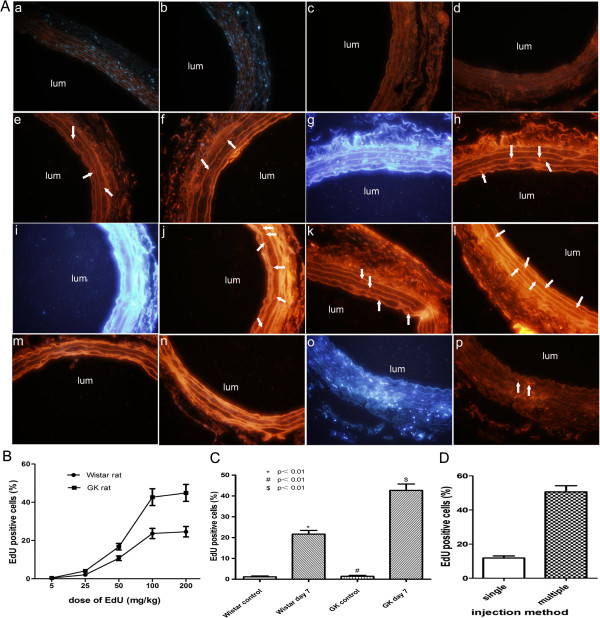
Representative images of EdU staining by different EdU injection methods (magnification ×400). (A) Three intraperitoneal injections of EdU at day 7 after balloon injury (a-l): (a, c, e) EdU staining for Wistar rats at a dose of 5 mg/kg, 25 mg/kg and 50 mg/kg in sequence; (b, d, f) EdU staining for GK rats at a dose of 5 mg/kg, 25 mg/kg and 50 mg/kg in sequence; (g-j) Hoechst 33342 and EdU staining for Wistar and GK rats at a dose of 100 mg/kg in order; (k, l) EdU staining for Wistar and GK rats at a dose of 200 mg/kg, respectively. (m, n) EdU staining for uninjuried Wistar and GK rats at a dose of 100 mg/kg, respectively. (o, p) Hoechst 33342 and EdU staining for GK rats at a single injection of 100 mg/kg, respectively. (B) Line charts depicting the dose dependence of EdU staining. (C) Bar diagrams showing the increased number of EdU-positive cells was more significant in the injury groups than in the uninjured groups for Wistar and GK rats at a dose of 100 mg/kg, respectively. (D) Bar diagrams showing a greater number of EdU-positive cells were observed using multiple injections than a single one. Arrows in images sign EdU-labeled cells and lums indicate luminal side of artery. * indicates Wistar control versus Wistar day 7, # indicates GK control versus GK day 7, $ indicates Wistar day 7 versus GK day 7. p<0.01.